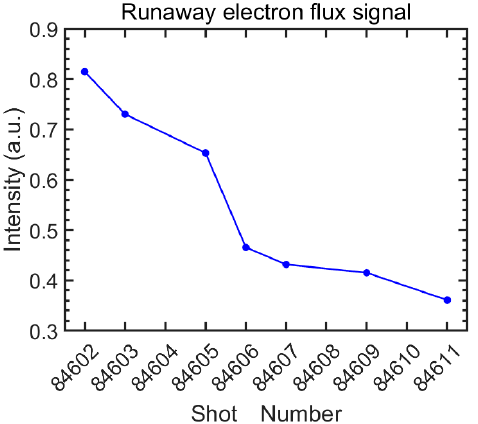
Figure 9. The averaged runaway electron flux signal during t = 3.0–6.0 s change in the discharges during lithium granule injection (#84602–#84611).